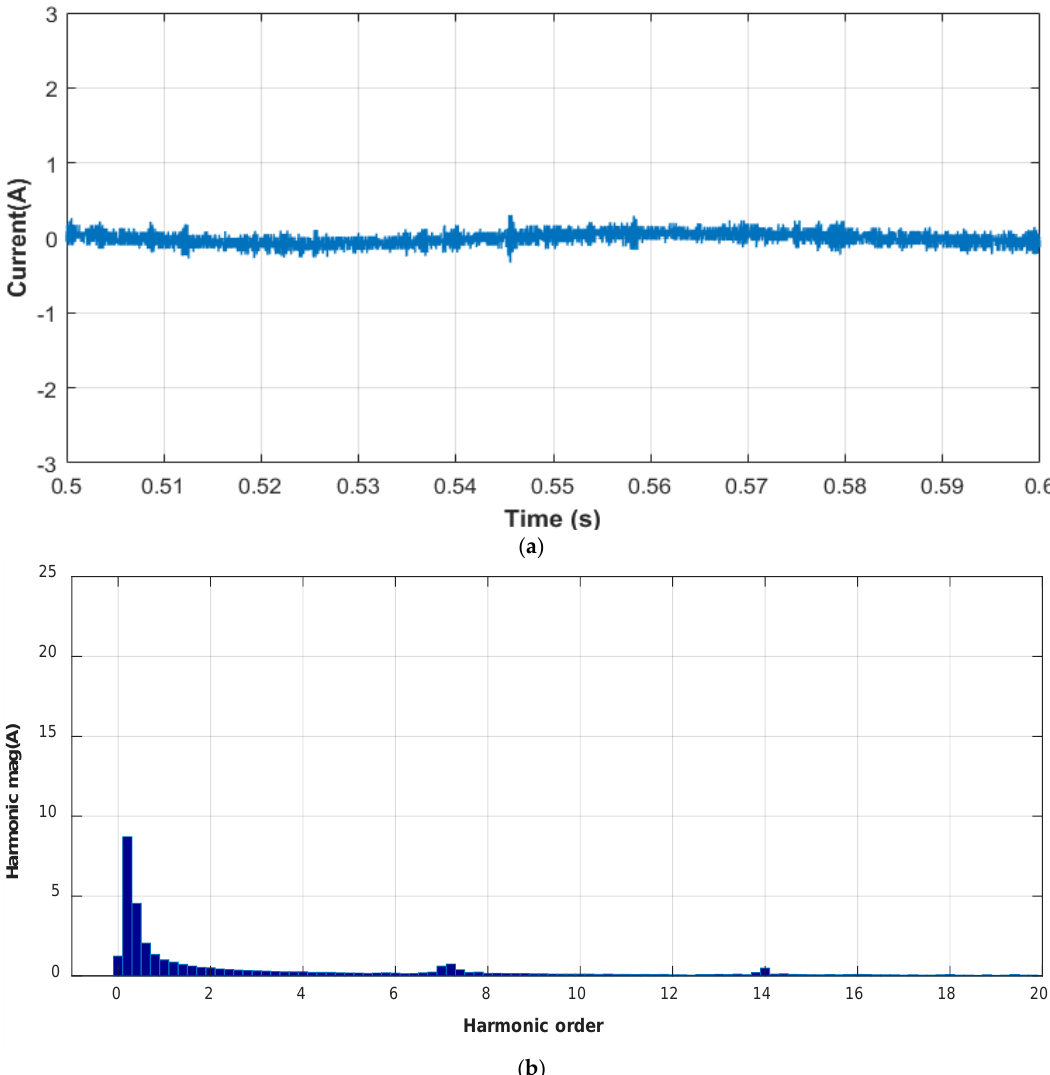
Figure 13. Simulation waveforms in parallel system with unequal inductance and with the proposed suppression strategy: ( a ) ZSCC of system; ( b ) harmonics contained in ZSCC.